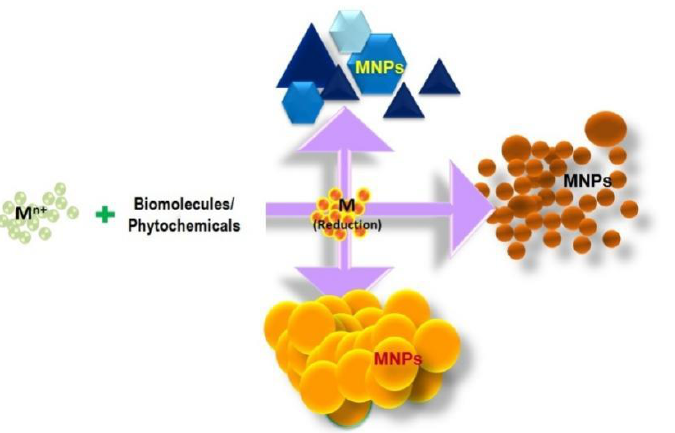
Figure 1. Schematic representation for the biosynthesis of different morphological metal nanopar-